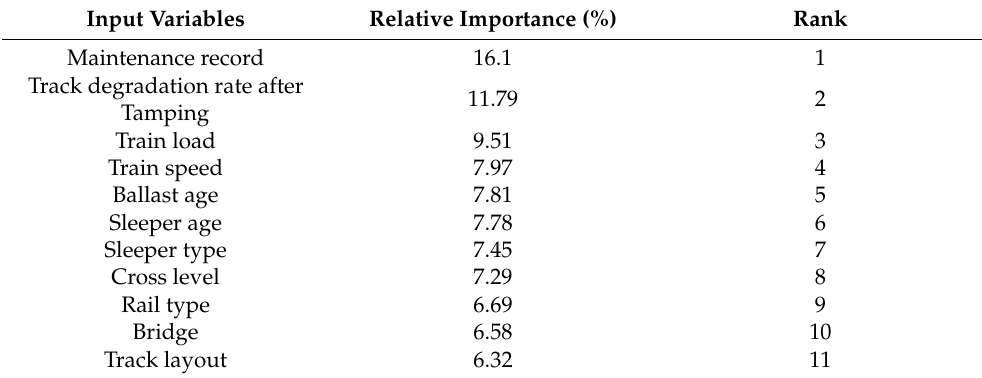
Table 5. Relative importance of input variables. Adapted from [93].